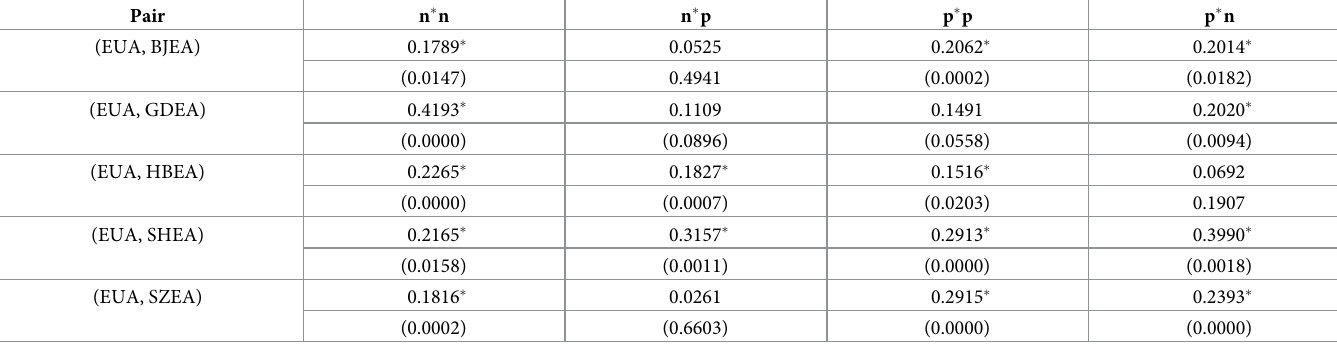
Table 6. Tail dependence test result for the EU ETS and China’s carbon market. Pair